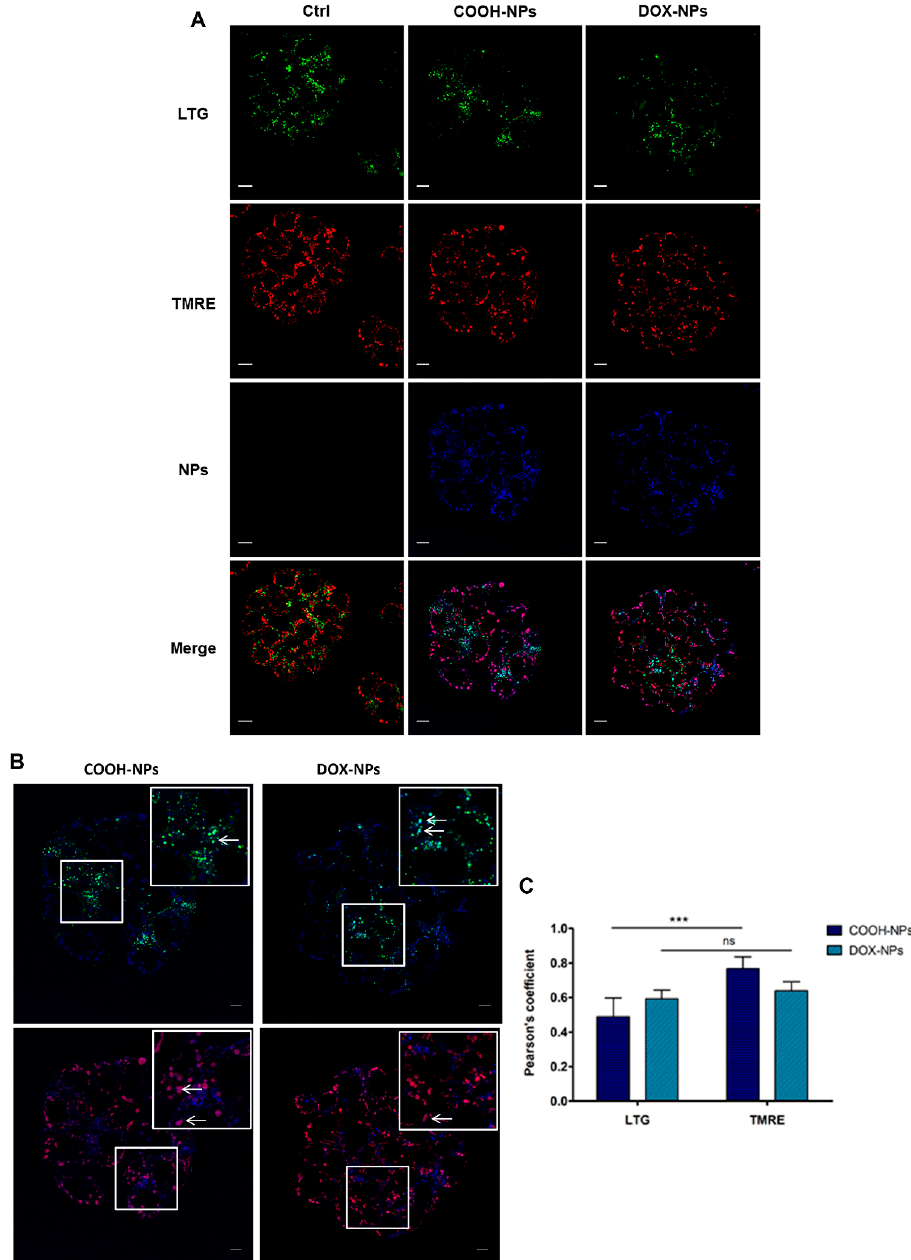
Figure 6. Intracellular investigation of COOH-NPs and DOX-NPs in MCF-7 cells: colocalization with lysosomes and mitochondria ( A ) Representative confocal images of MCF-7 cells incubated for 4 h at 37 °C with medium (ctrl), COOH-NPs (diluted 1:50) or DOX-NPs (1 µg/mL of drug) and then stained with LysoTracker green (LTG) and tetramethylrhodamine ethyl ester perchlorate (TMRE), respectively for lysosomes and mitochondria. Figures show LTG (green), TMRE (red), SiNPs (blue) and merged images (last line at the bottom). Teal and violet colors indicate colocalization between, respectively, LTG/NPs and TMRE/NPs. Scale bar: 10 µm. ( B ) Merge of LTG and TMRE in MCF-7 with COOH-NPs and DOX-NPs. Magnification of inset regions are shown. White arrows display colocalization points. Scale bars, 10 µ m. ( C ) Pearson’s colocalization coefficient (PCC) of LTG and TMRE with COOH-NPs and DOX-NPs in MCF-7 cells. PCCs were derived from two completely independent experiments with 8 fields per experiment contributing to the cumulative result. Each value is expressed as PCC ± sd; asterisks denote a statistically significant difference (*** = p < 0.001, ns = p > 0.05) between LTG and TMRE colocalization with